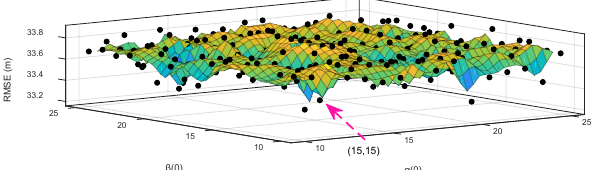
Figure 3. RMSE of the localization (linear observation equation).